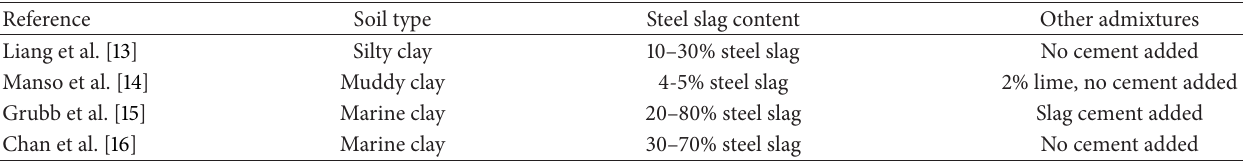
Table 2: Steel slag contents in soil-slag mixtures.